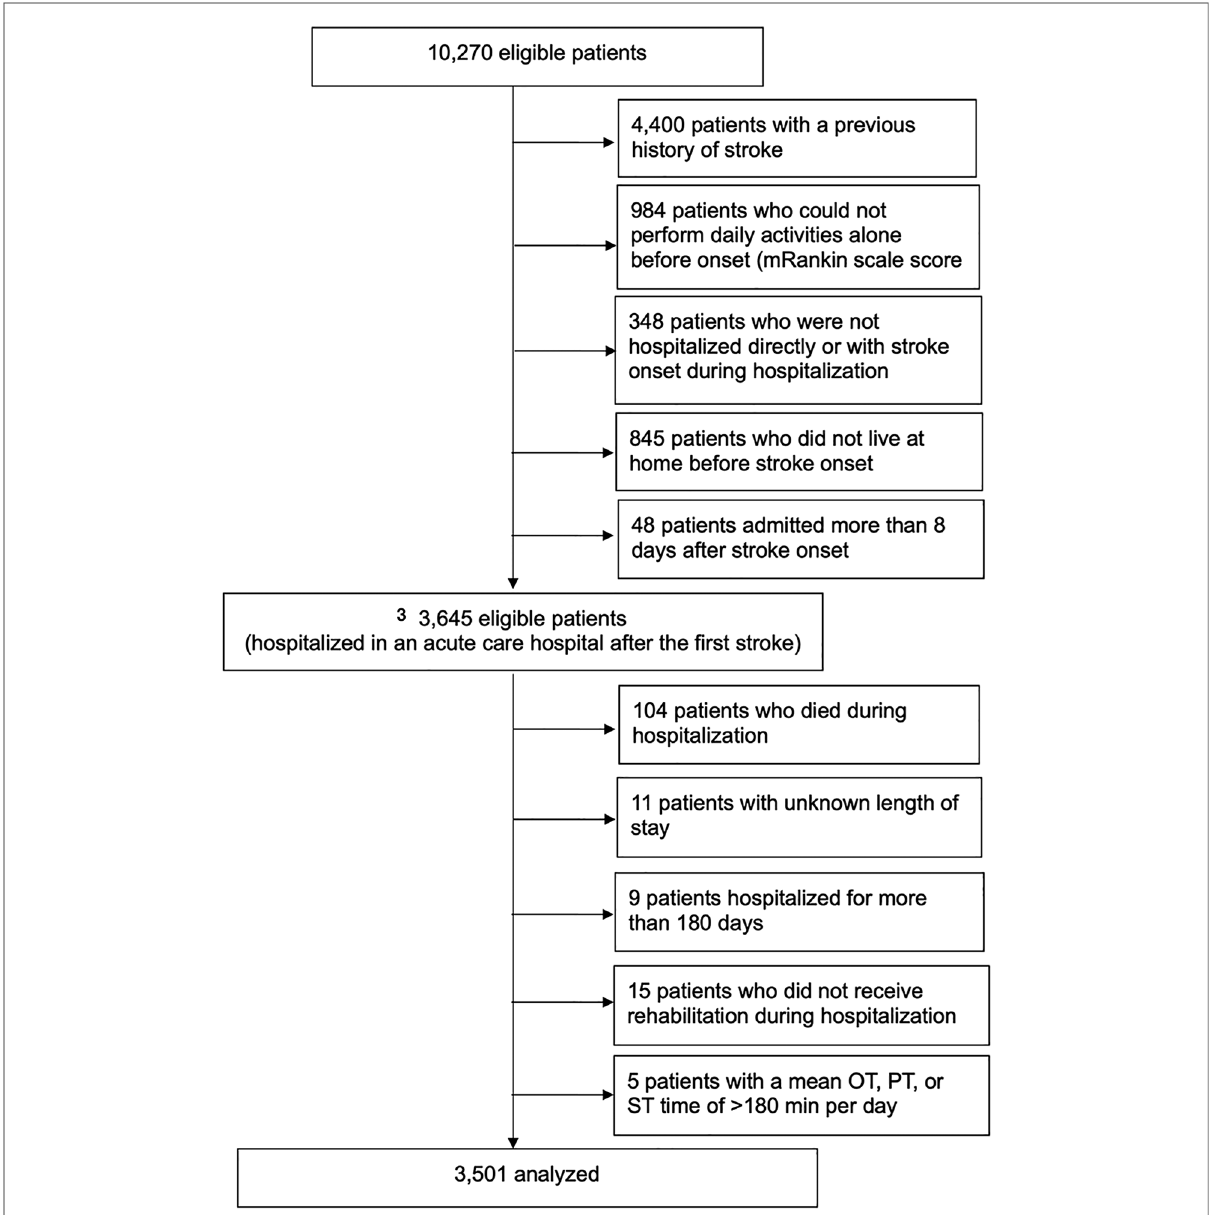
FIGURE 1 Study fl owchart and patient selection. OT, occupational therapy; PT, physical therapy; ST, speech therapy. Final analysis patients were divided into the AOT and non-AOT groups. AOT and non-AOT were de fi ned as daily OT intervention times (total intervention time/length of hospital stay) longer or shorter than the daily physical therapy intervention times,